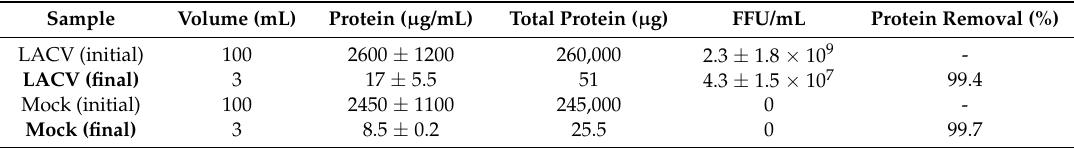
Table 1. Evaluation of LACV purification by flow-through chromatography. Supernatants of LACV-infected or mock-infected Vero E6 cells were purified by flow-through chromatography and protein concentrations and virus titers were determined at the beginning and the end of the purification process. The results are the mean ± S.D. of three independent batches.